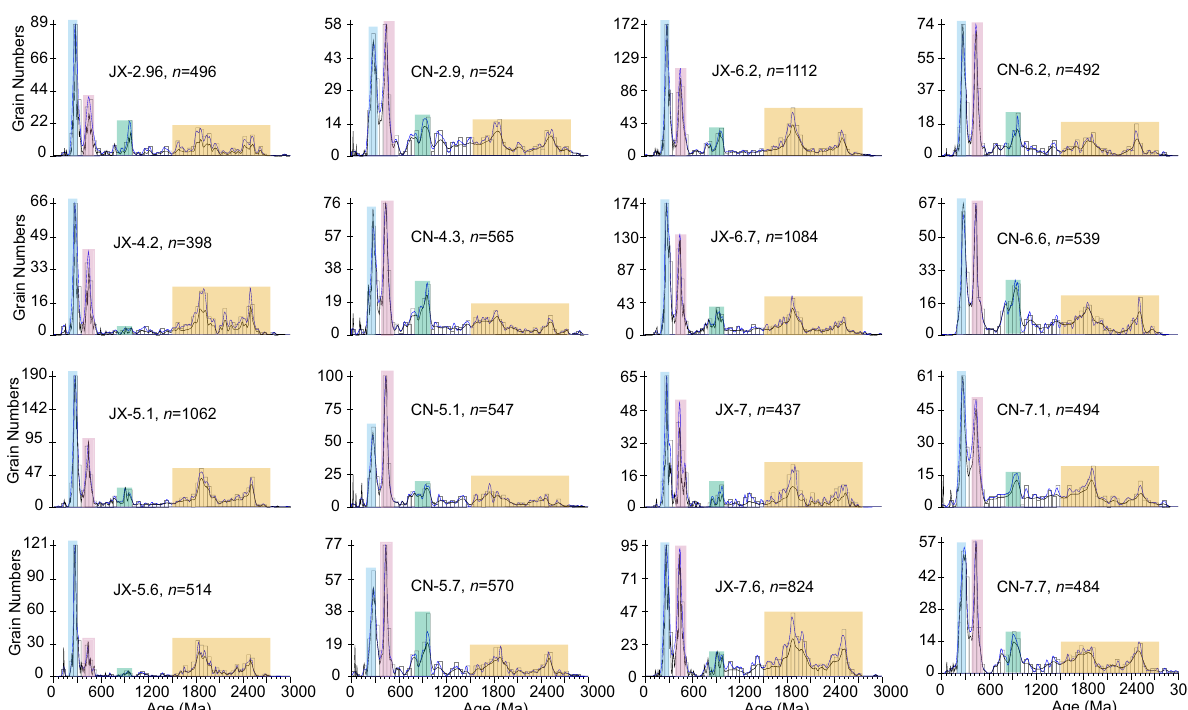
Fig. 6 A comparison of detrital zircon U-Pb ages from the northeastern and central-western CLP. Black and blue lines are normalized probability density function (PDP) and kernel density estimation plots (KDE), respectively, and open rectangles are age histograms. From left to right, the blue, purple, green and orange shadows indicate the ages in the range of 200 – 300 Ma, 400 – 500 Ma, 800 – 1000 Ma, and 1500 – 2750 Ma, respectively. JX-Jiaxian from the northeastern CLP; CN-Chaona from the central-western